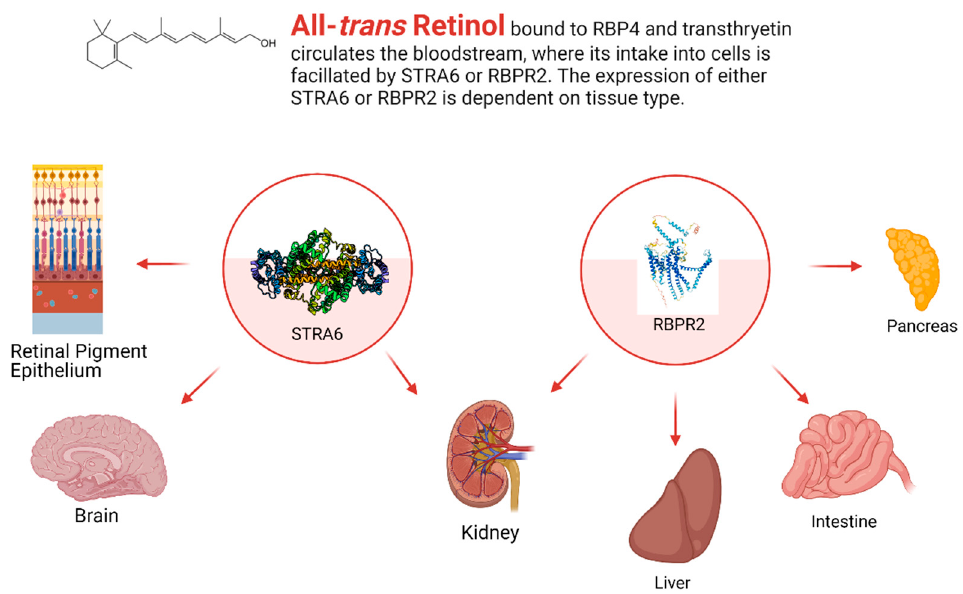
Figure 3. The general expression pattern of STRA6 and RBPR2. Again, STRA6 and RBPR2 share expression within the kidney, with mutually exclusive expression in all other organ systems [30,35,39,40]. Created with BioRender.com.